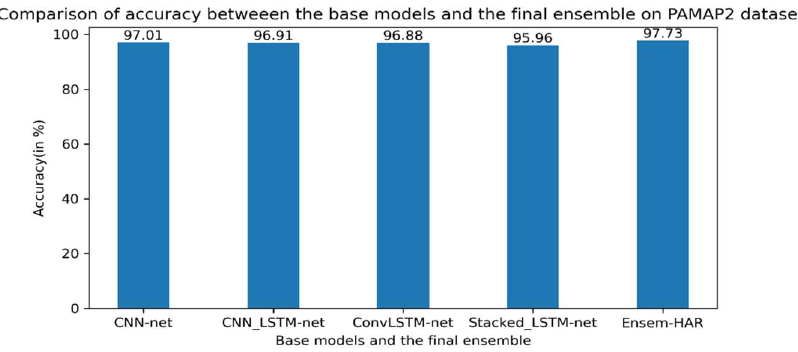
Figure 15. Accuracy (in %) comparison between four base models and Ensem-HAR model on the PAMAP2 dataset.